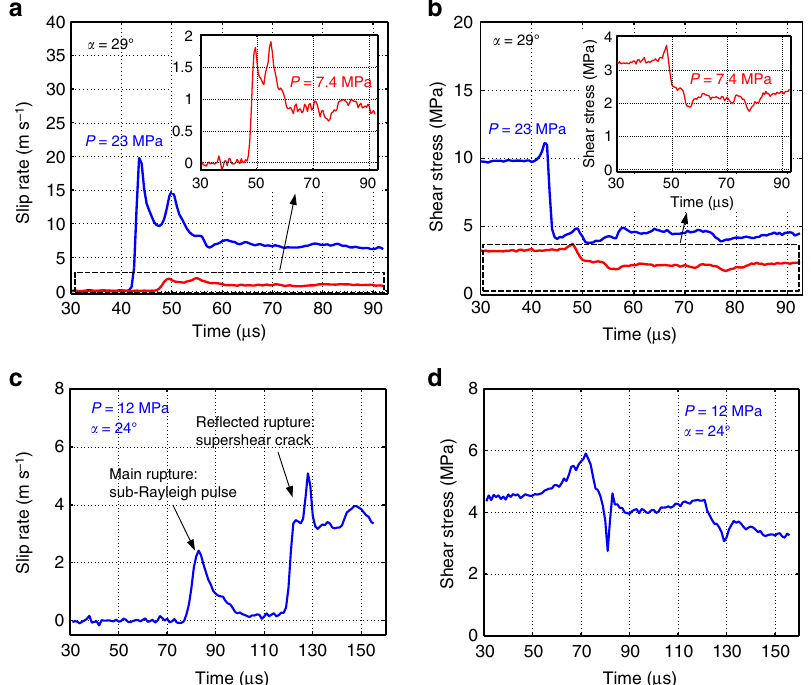
Figure 4 | Monitoring the laboratory earthquake vitals. ( a ) Slip rate and ( b ) shear stress time histories obtained on the interface at the center of the field of view shown in Fig. 1 for two far field loads, P ¼ 23MPa (blue) and P ¼ 7.4MPa (red), and angle a ¼ 29 (cid:2) ; both cases result in supershear ruptures. Insets: Magnified slip rate and shear stress time histories for the case P ¼ 7.4MPa. The rupture produced by the higher far-field load has an order of magnitude higher peak slip rate and a more prominent reduction in shear stress compared to the lower load case. Yet the two ruptures are qualitatively similar as demonstrated by the insets. ( c ) Slip rate and ( d ) shear stress time histories for P ¼ 12MPa and a ¼ 24 (cid:2) . This experiment has a very different slip-rate history, with a sub-Rayleigh pulse-like rupture propagating first, followed by a reflected supershear crack-like angle a ¼ 29 (cid:2) ; both cases result in supershear ruptures. For the two loads, rupture exhibits a rapid increase of slip rates towards a peak value and subsequent decay to near-constant values (Figs 4a and 5c), although the level of slip rates is quite different between these two cases: the peak slip rate is B 2 and B 20 m s (cid:2) 1 for the lower and higher load case, respectively. The rupture produced by the higher far-field load also has a higher overall level of shear stress and a more pronounced reduction in shear stress compared